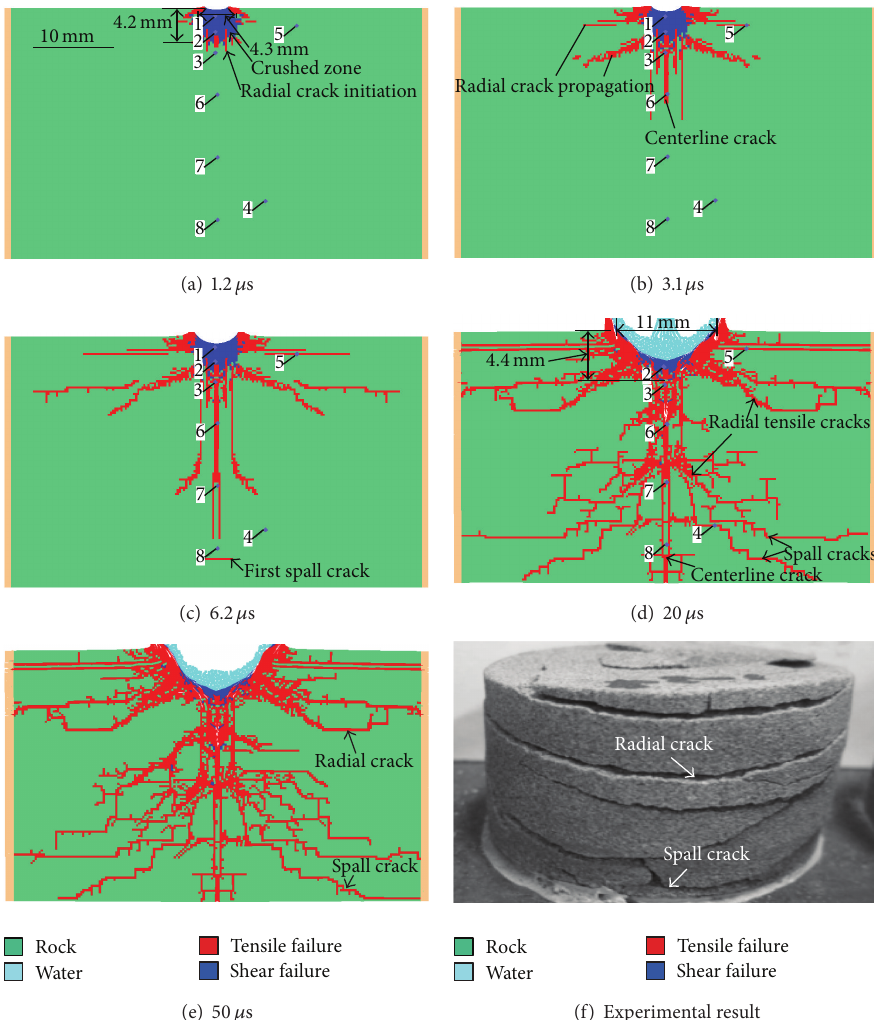
Figure 3: Rock status as a function of time by water jet